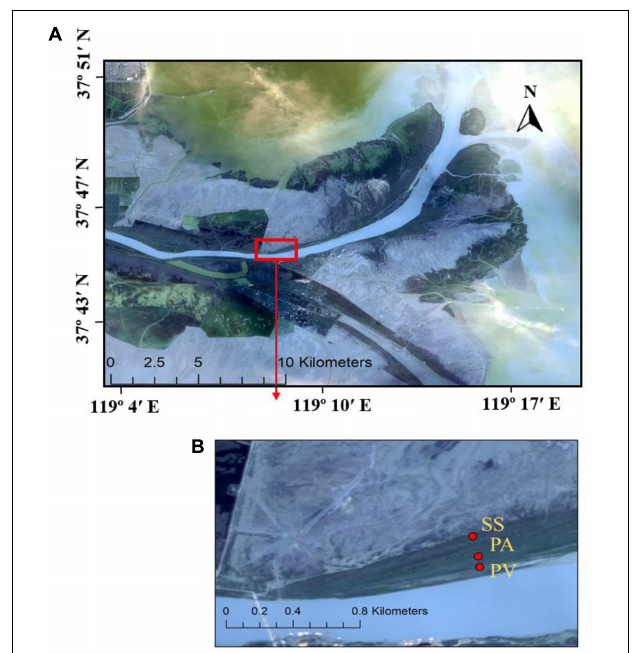
FIGURE 1 | Location map of sampling sites in the YRD. (A) The location of sampling belt in the YRD, (B) the location of sampling sites in the sampling